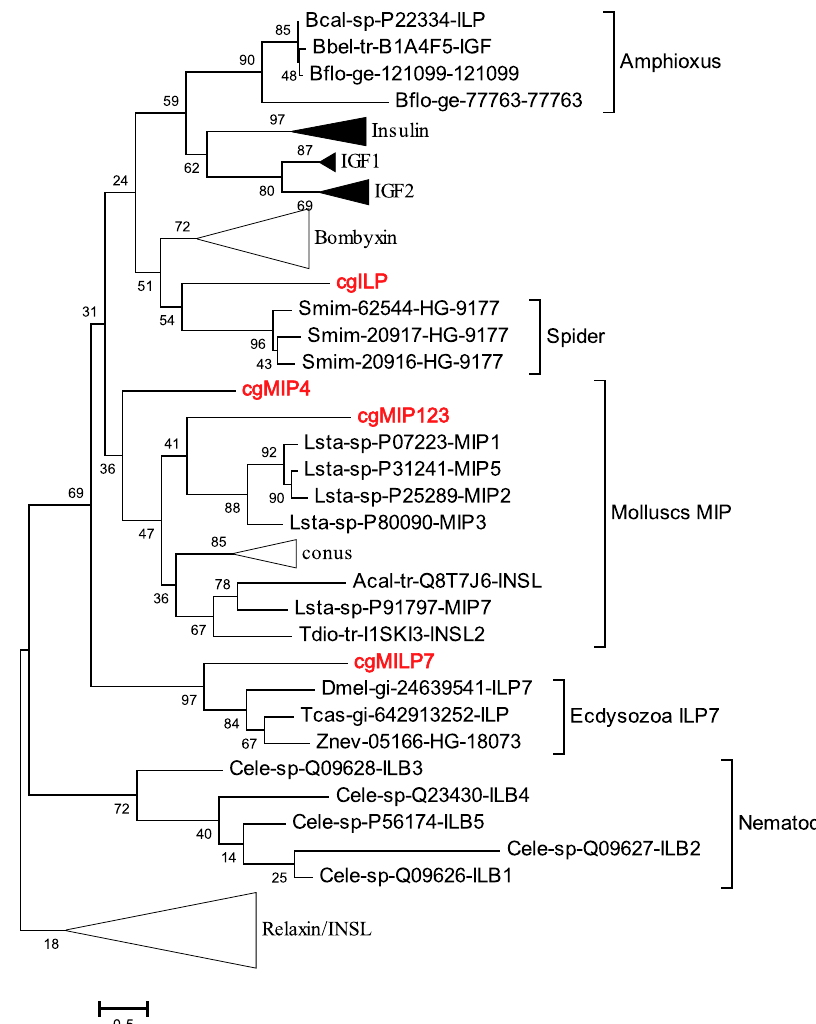
Fig. 1 Phylogenetic analysis of insulin-related peptides (RAxML method). Species: Bcal Branchiostoma californiense (California amphioxus), Bbel B. belcheri tsingtauense (Chinese amphioxus), B fl o B. fl oridae (Florida amphioxus), Cgig Crassostrea gigas (Paci fi c oyster), Smim Stegodyphus mimosarum (spider), Lsta Lymnaea stagnalis (snail), Acal Aplysia californica (sea hare), Tdio Tritonia diomedea (sea slug), Dmel Drosophila melanogaster (fruit fl y), Tcas Tribolium castaneum (beetle), Znev Zootermopsis nevadensis (termite), Cele Caenorhabditis elegans (nematode). Some species are covered by collapsed sub-trees, see Supplementary Data 1, Figs. 1 and 2 for